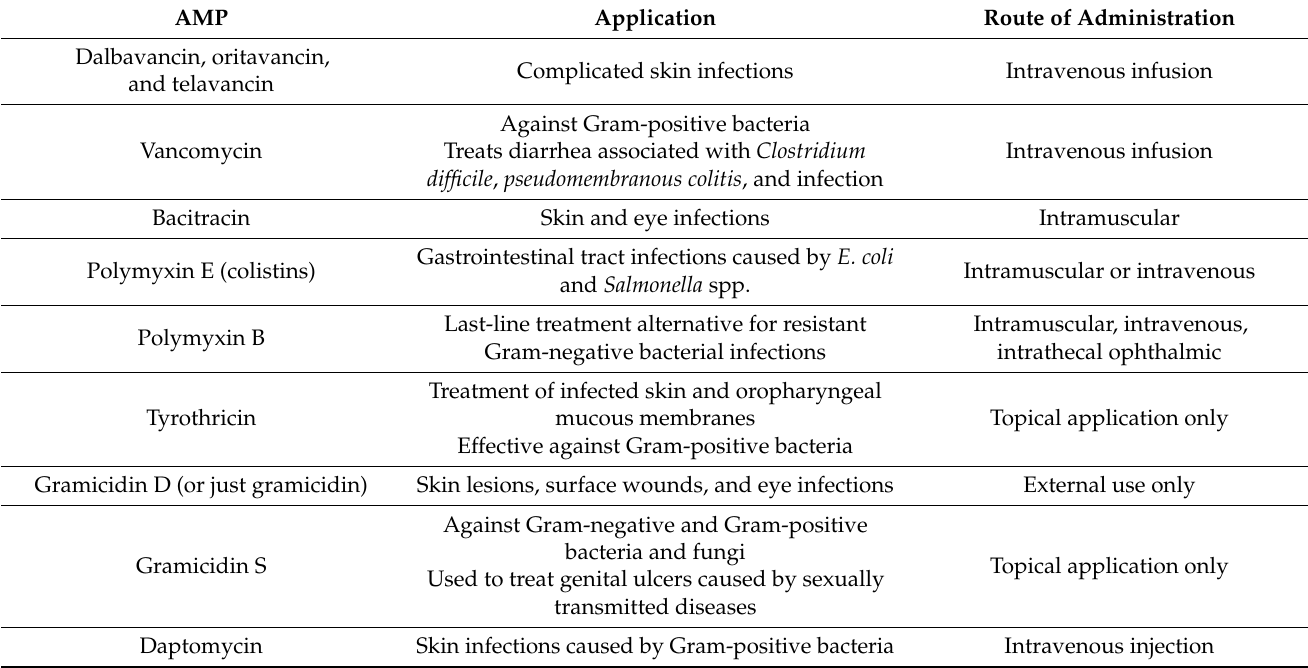
Table 6. AMPs approved for clinical use by the FDA